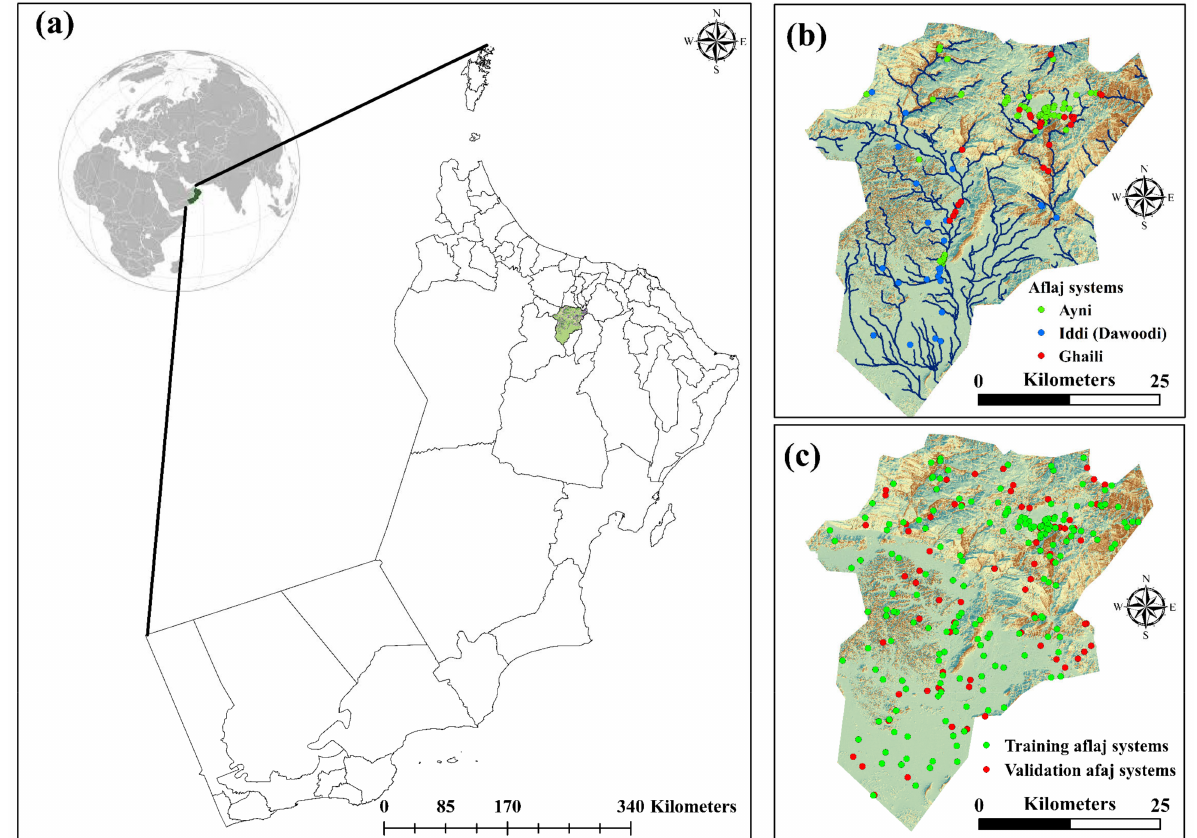
Figure 1. ( a ) Location of the study area, ( b ) Aflaj locations with elevation 5 × 5 m obtained from National Survey Authority, Oman, ( c ) Training and validation data of the aflaj